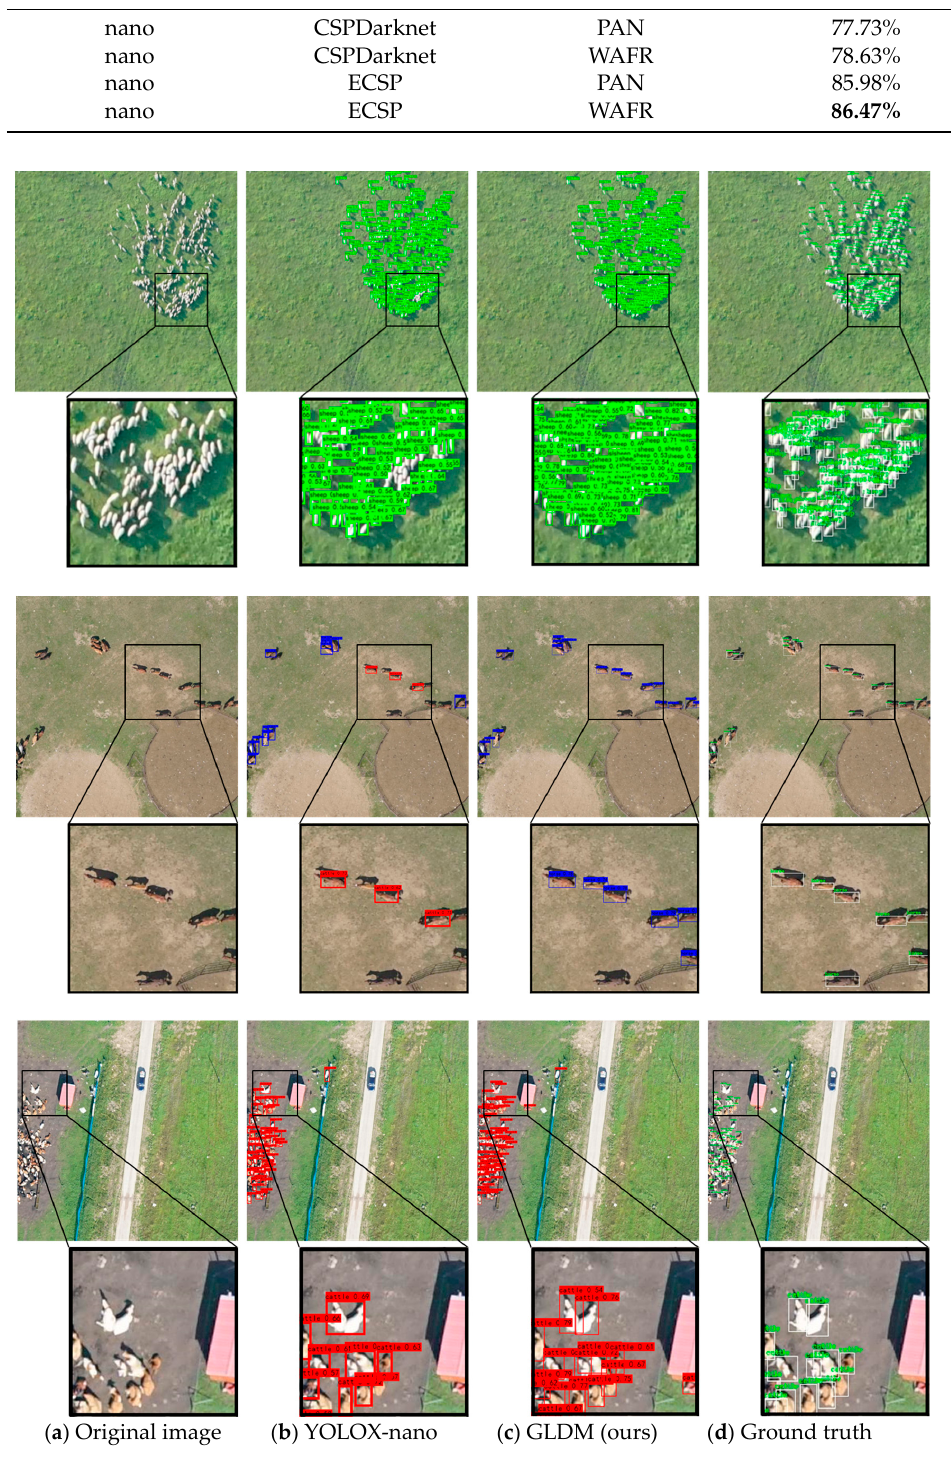
Figure 13. Comparison of detection results before and after model improvement.